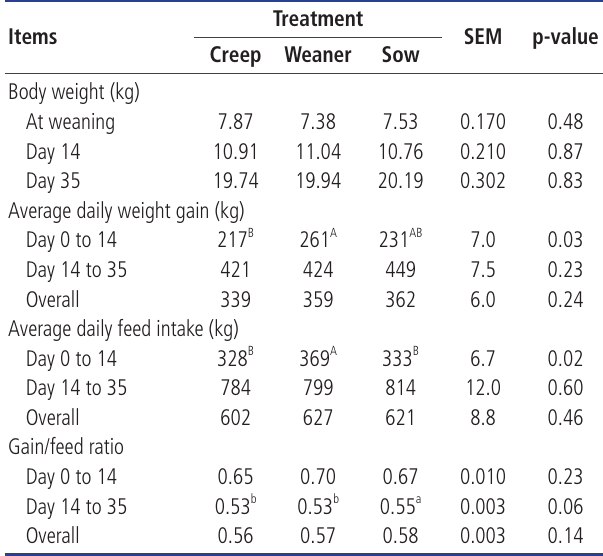
Table 4. Effect of supplementation of different creep feed types during lactating period on piglet performance after weaning Items